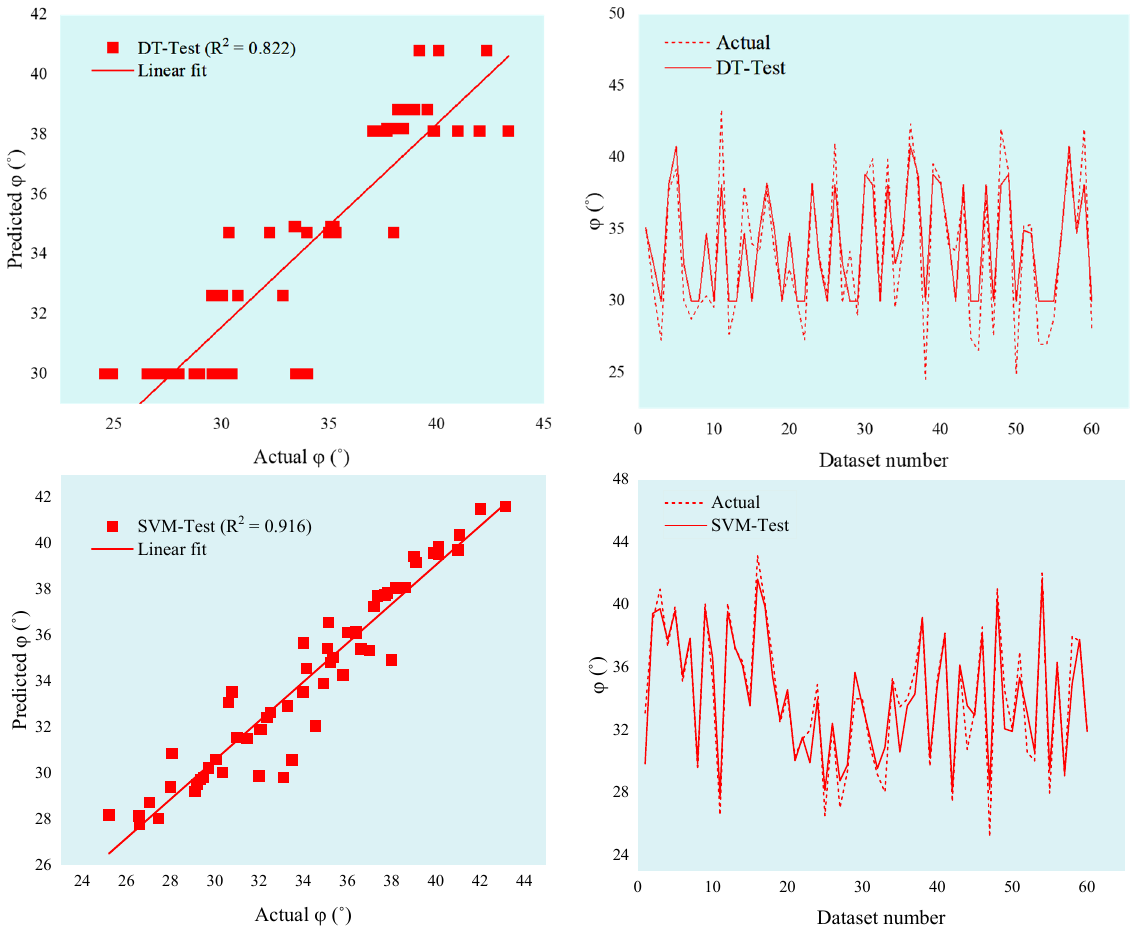
Figure 4. Performance plots of LR, RR, DT, and SVM models for the ϕ ( ◦ ) at the testing level. In the same manner, Figure 5 shows a comparison of scatter plots and performance plots between the actual and predicted values of the c (MPa) at the test level for the LR, RR, DT, and SVM models. Based on the test prediction, the R 2 of each model is computed. The R 2 values of LR, RR, DT, and SVM models for the c (MPa) are 0.928, 0.934, 0.961, and 0.977, respectively.